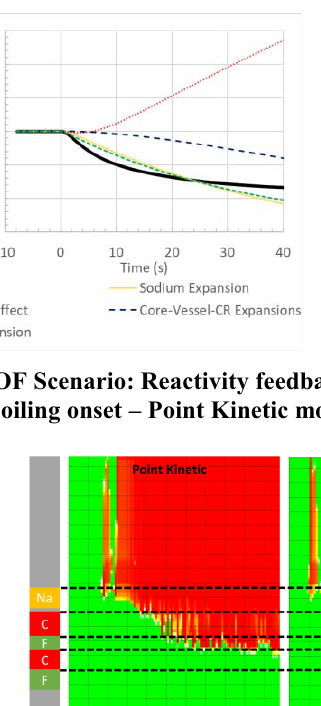
Figure 5 : ULOF Scenario: Reactor Power & Flow rate – Comparisons Point and Adiabatic Models